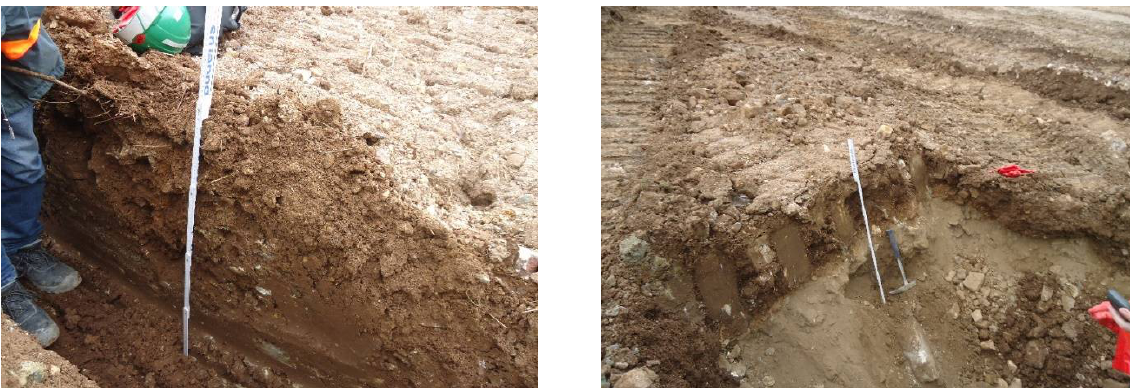
Figure 5. Indicative soil trenches after remediation of the old arsenopyrites concentrate storage area (former METBA plot).